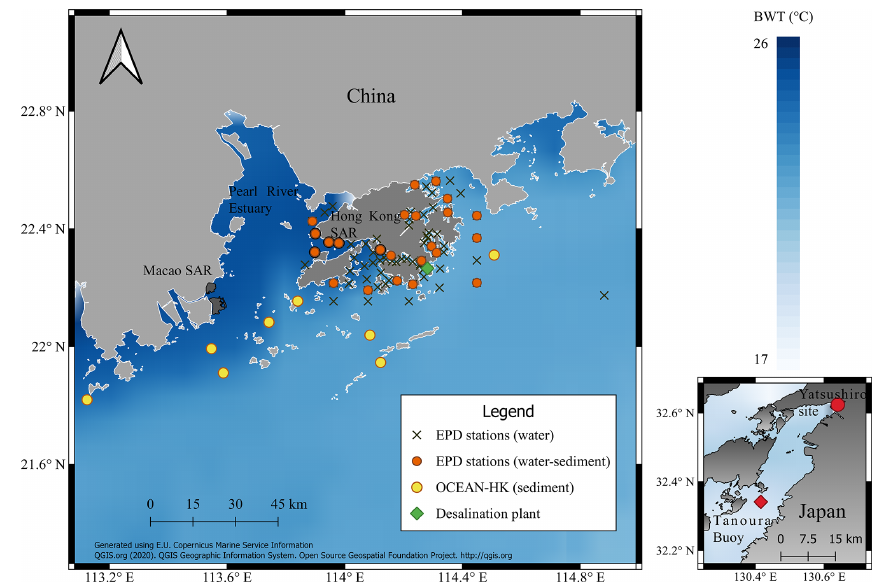
Figure 1. Sampling sites around the Pearl River estuary (PRE) and the Yatsushiro bay in Japan. Ostracods were collected from sediment samples obtained by the Environmental Protection Department of Hong Kong (EPD) and OCEAN-HK in Hong Kong. Monthly water quality data were obtained from different sampling locations across Hong Kong (EPD stations). Mean bottom-water temperature (BWT) for the year 2011 was obtained from the satellite product of the Copernicus Marine Environment Monitoring Service (CMEMS). Table 1. Detection limit (DL), accuracy (acc.) and precision (RSD) of the standards used to assess the analytical quality of the measurements. Ratios DL JCp-1 ratio JCp-1 acc. JCp-1 RSD MES2 ratio MES2 acc. MES2 RSD (mmolmol − 1 ) (mmolmol − 1 ) (%) (%) (mmolmol − 1 ) (%) (%) Mg / Ca 0.7 4.2 0.2 3.7 25.4 − 2 . 7 2.7 Sr / Ca 0.1 8.7 − 2 . 5 2.9 7 − 2 . 5 3.3 Al / Ca 1.4 1.9 > 20%* > 20%* 22.9 − 2 . 2 3.0 Fe / Ca 1.0 0.05 Below DL Below DL 11 − 2 . 2